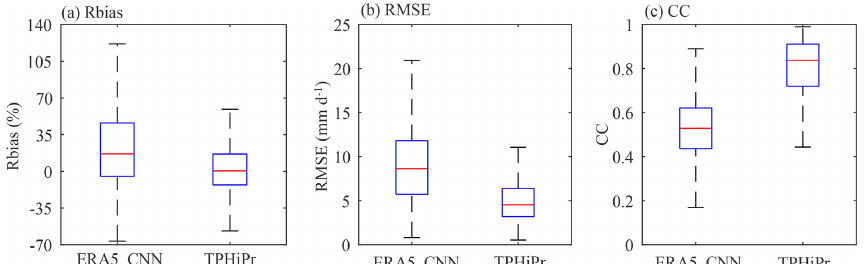
Figure 4. Comparison of error metrics for ERA5_CNN and TPHiPr at 966 independent rain gauges. The box represents the distribution of the metrics for all the independent rain gauges in the